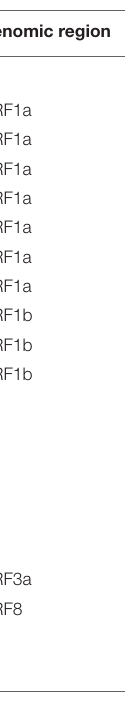
TABLE 1 | Lineage P.4 defining